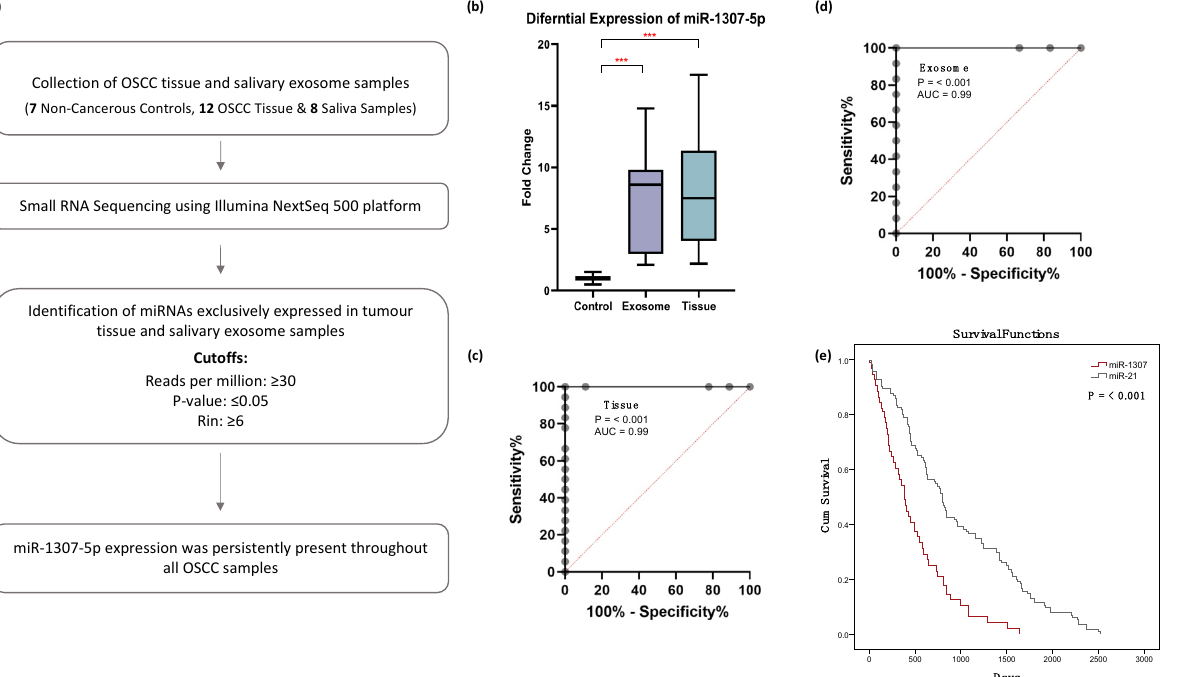
Figure 2. miR-1307-5p is differentially expressed and predicts poor overall survival in oral cancer patients ( a ) Data analysis pipeline for small RNA sequencing. ( b ) Box plots representing the expression of miR-1307-5p in 12 salivary exosomal samples of OSCC patients and 19 OSCC tissue samples compared to healthy controls. The expression levels of miRNAs were estimated using real-time PCR. The combined measure of sensitivity and specificity miR-1307-5p was 99.99% across ( c ) tissue and ( d ) exosome samples (AUC:0.99, 95 % CI, p < 0.001) Diagonal reference line acts as a performance measure of the diagnostic test. Note: AUC: Area Under the Curve, CI: Confidence Interval. ( e ) Kaplan–Meier plot of overall survival of miR-1307-5p and miR-21 generated from data available on TCGA_HNSC and data obtained from literature. The expression levels of miRNAs were estimated using real-time PCR. The data were normalised with U6 values, and the relative expression of miRNAs was analysed using the ddCt method. Buccal scrapings and saliva samples obtained from healthy controls were used to calculate the relative expression of miR-1307-5p in OSCC tissue and salivary exosomes respectively. Error bars represent mean ± SD of three independent experiments (*** p ≤